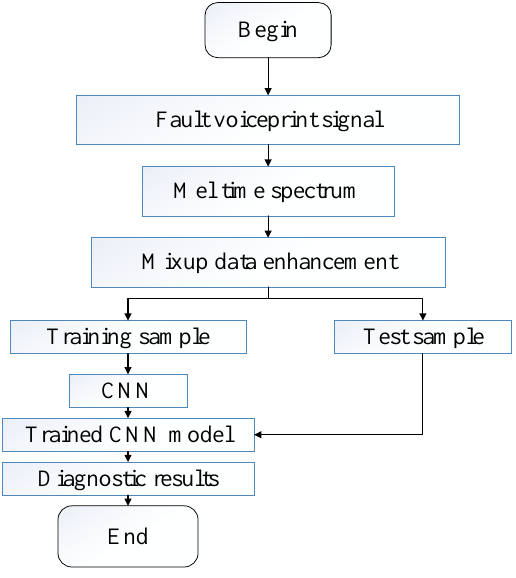
Figure 5. Diagnostic